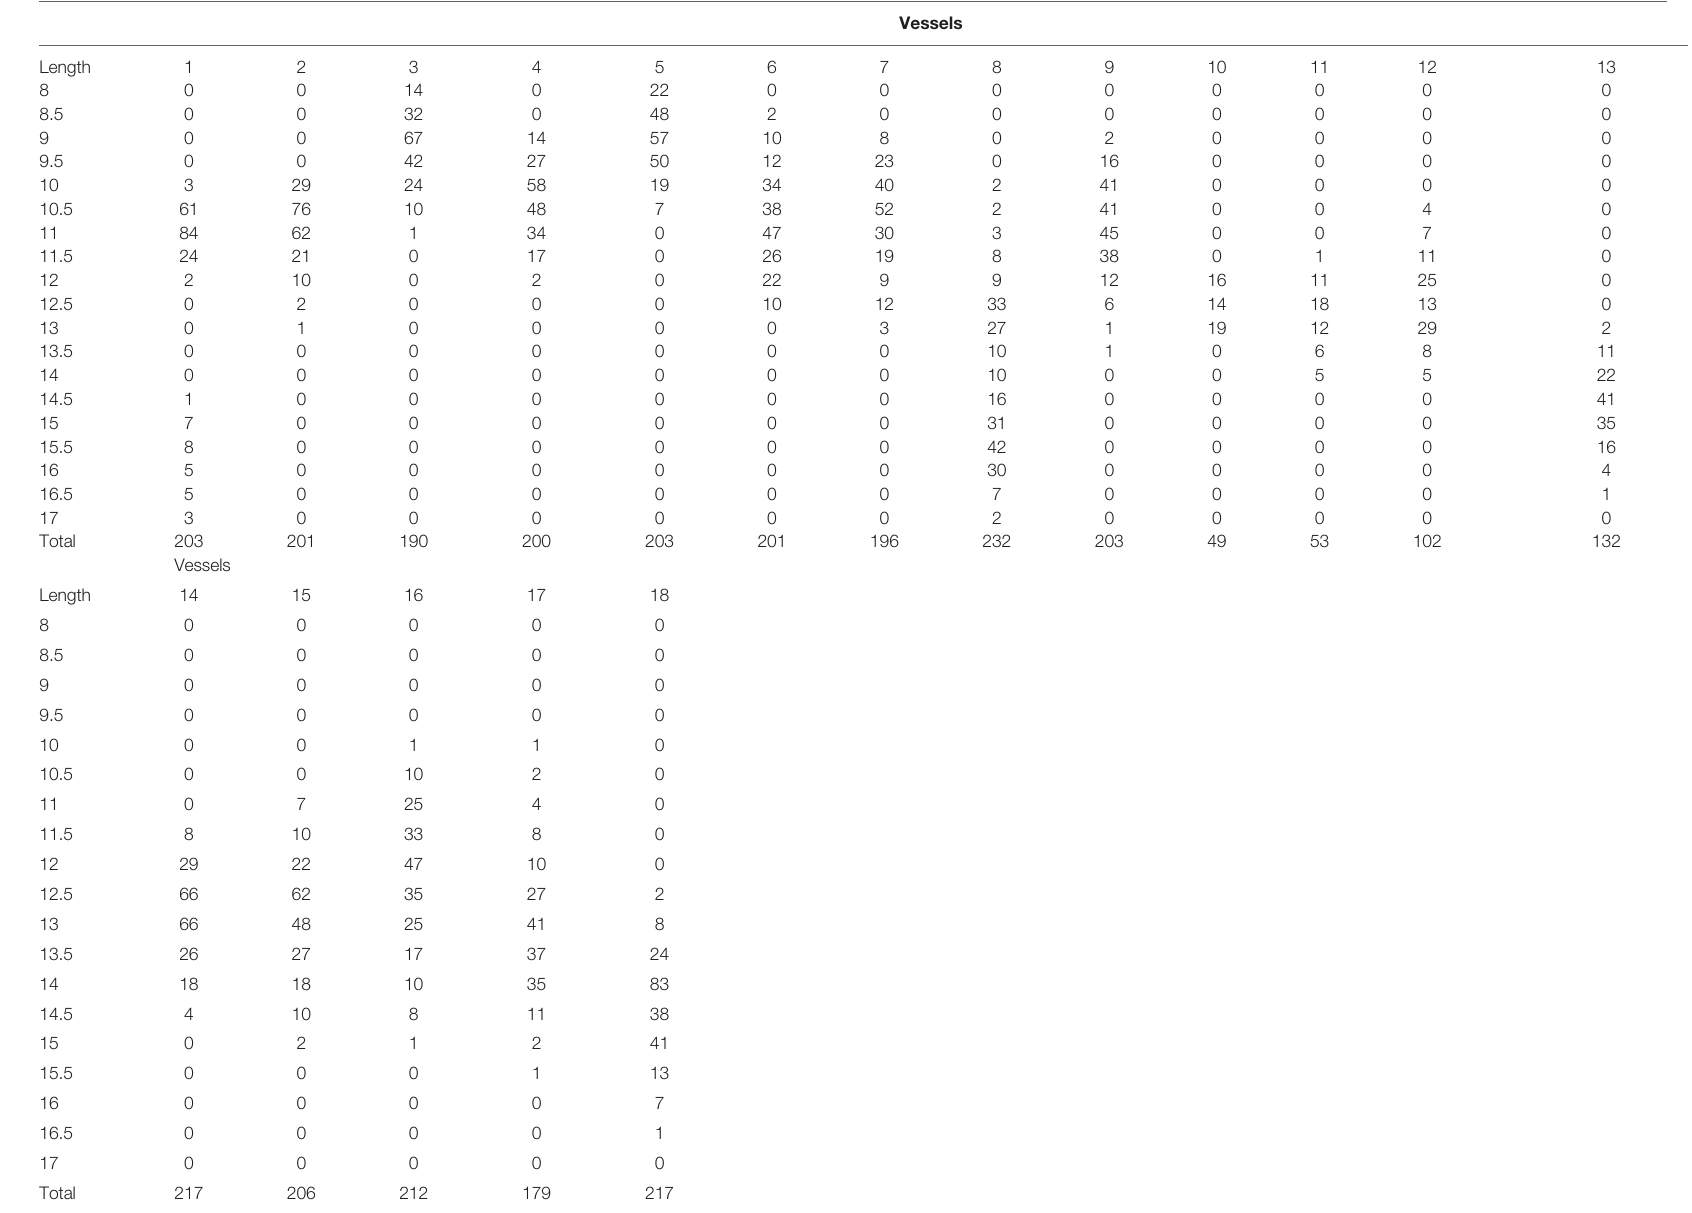
TABLE 3 | Biological data of commercial fi shing (vessels 13, 16, and 17) and research fi sheries. For each vessel and length, the number of sample individuals is